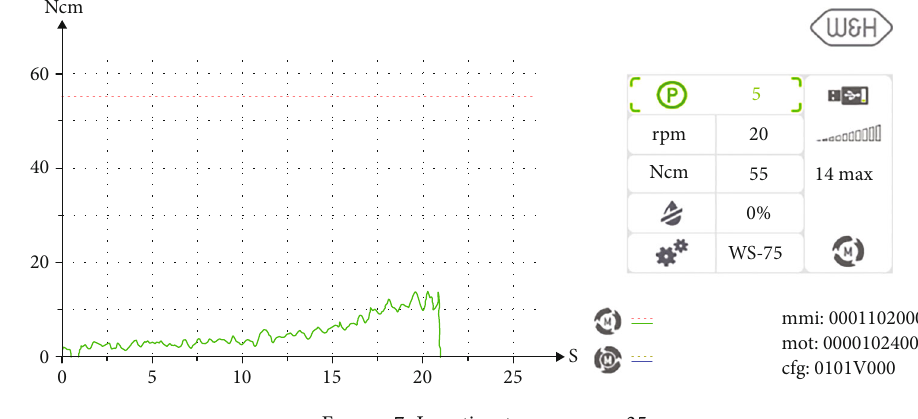
Figure 7: Insertion torque curve 35.